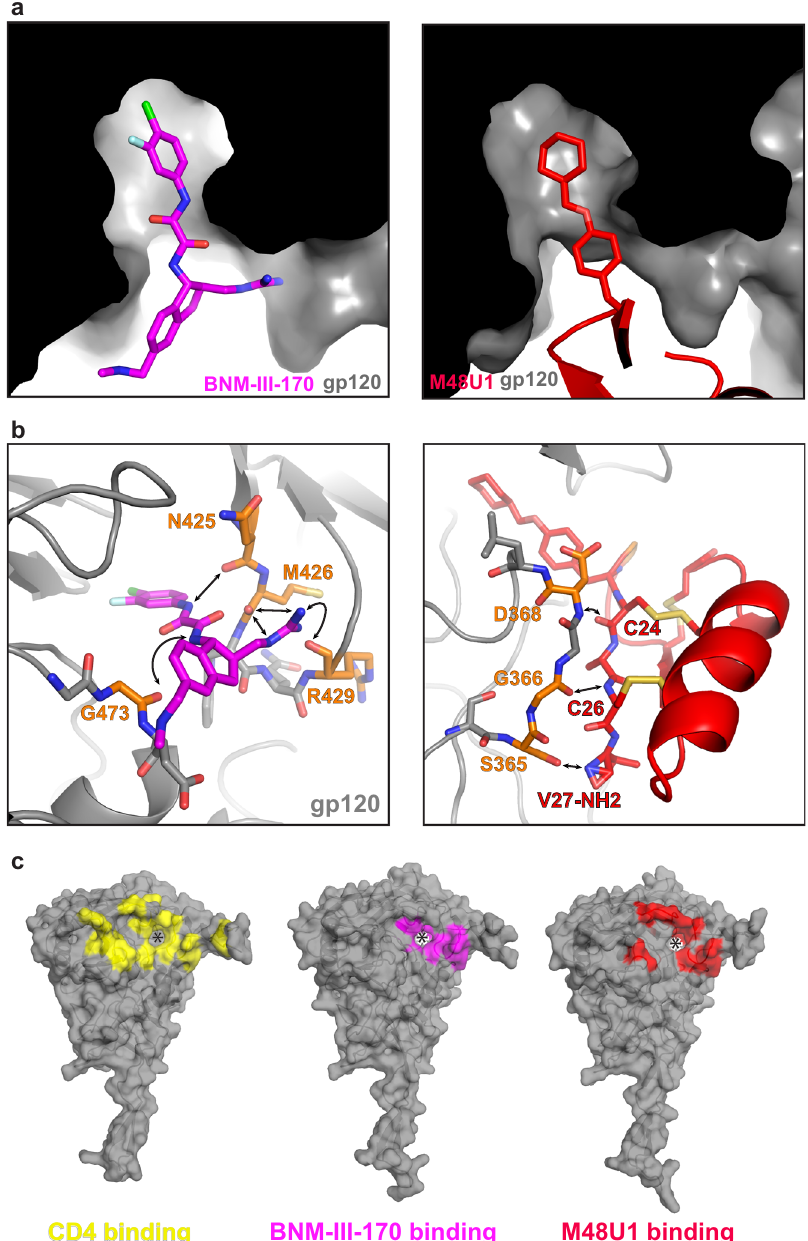
Fig. 2 BNM-III-170 and M48U1 binding to the gp120 Phe43 pocket. Atom colors: carbon = magenta (BNM-III-170), red (M48U1), or orange (gp120), nitrogen = blue, oxygen = red, sulfur = yellow, chlorine = green; fl uorine = cyan . a Cut-away side view of gp120 showing BNM-III-170 or M48U1 inserting into Phe43 pocket cavity of gp120 (black/gray). b Left: Stick model of BNM-III-170 within gp120 Phe43 pocket. Potential interactions between BNM-III-170 and backbone atoms of gp120 residues indicated by an arrow pointing to colored atoms of gp120 residues (sidechains omitted for clarity). Right: Stick and cartoon model of M48U1 within gp120 Phe43 pocket. c Surface rendering of gp120 showing interacting residues for sCD4 (PDB: 6U0L [10.2210/pdb6U0L/ pdb], left, yellow), BNM-III-170 (middle, magenta), or M48U1 (right, red). Highlighted residues are 4 Å or less from the bound molecule. gp120 = gray, * = Phe43 cavity